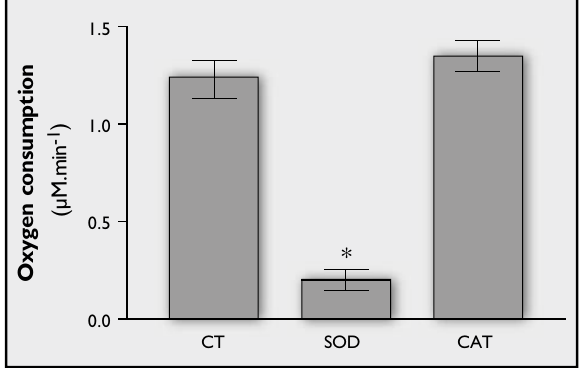
Figure 1 – Oxygen consumption during autoxidation of 1mM catechol in 1mM HCl, 50mM phosphate buffer (pH 7.4) at 37°C. Catechol was tested alone (CT, n = 13), in the presence of 17U superoxide dismutase (SOD, n = 3), or in the presence of 100IU catalase (CAT, n = 3). Each value represents the mean ± SEM; *p < 0.0005